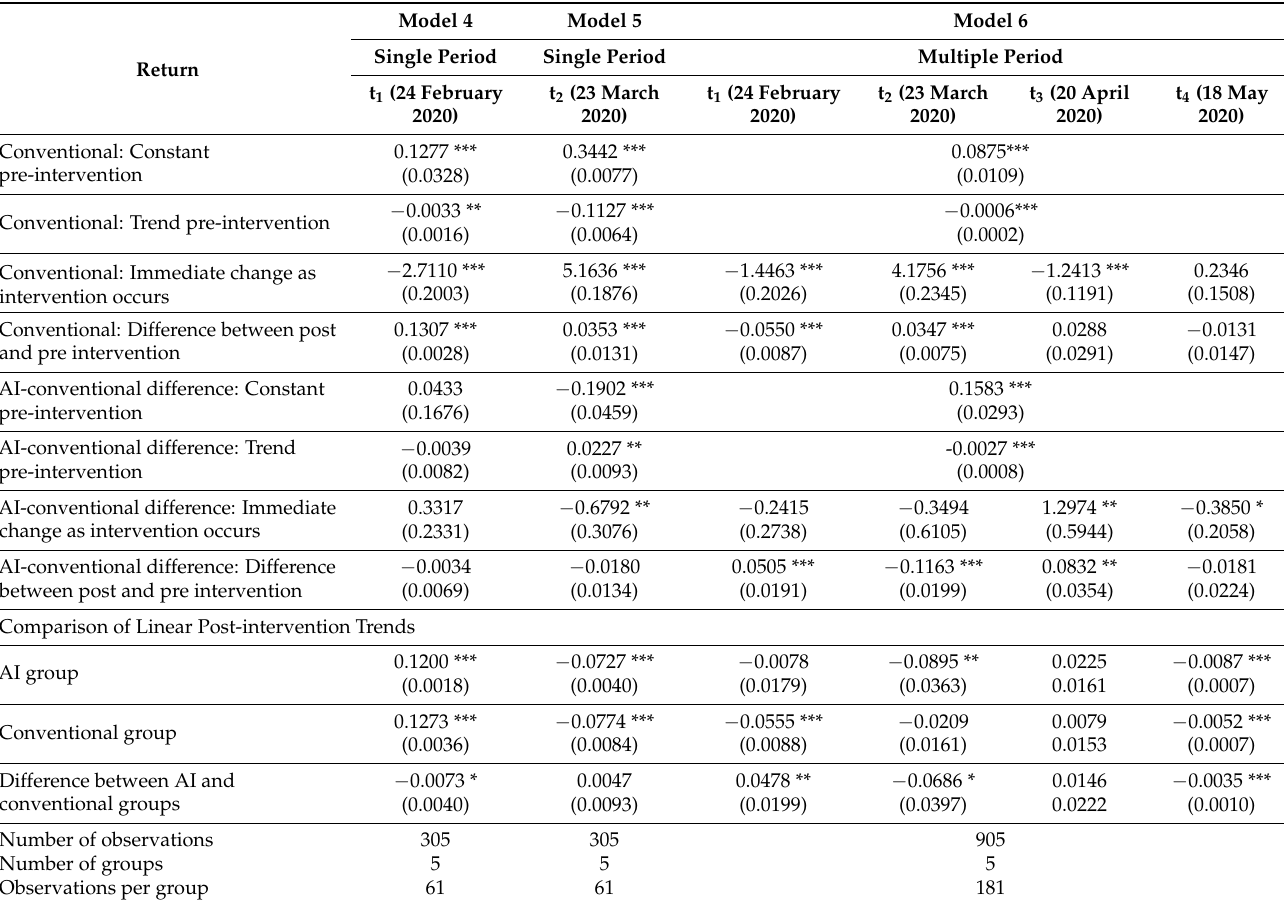
Table 5. Multiple-group analyses for artificial intelligence and conventional market groups with single and multiple